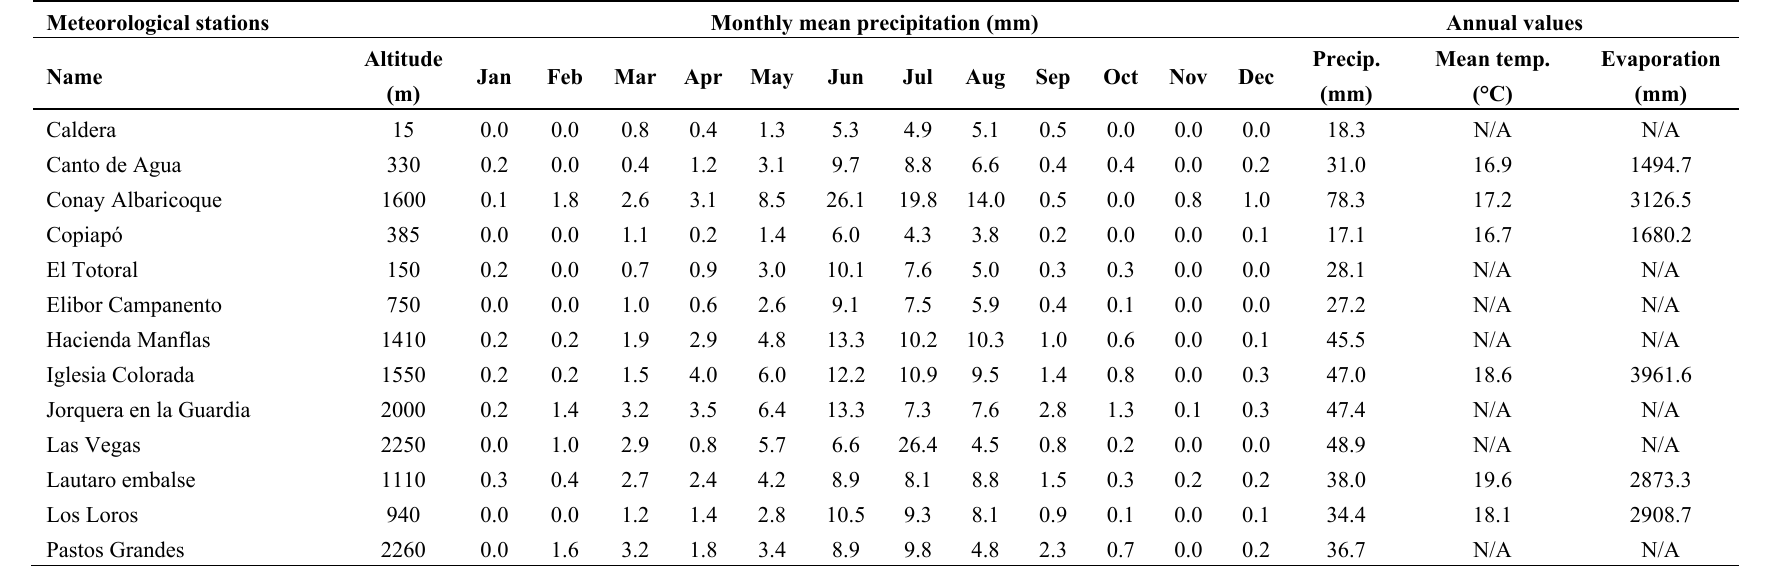
Table 1. Hydrometeorological data at selected